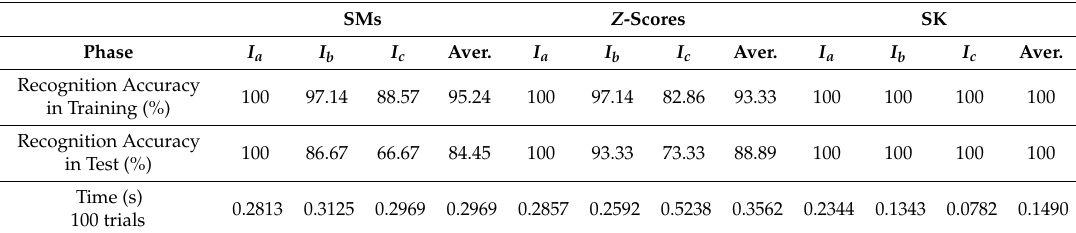
Table 2. Results of SLGF on the line faults with the SVM. SMs: statistical